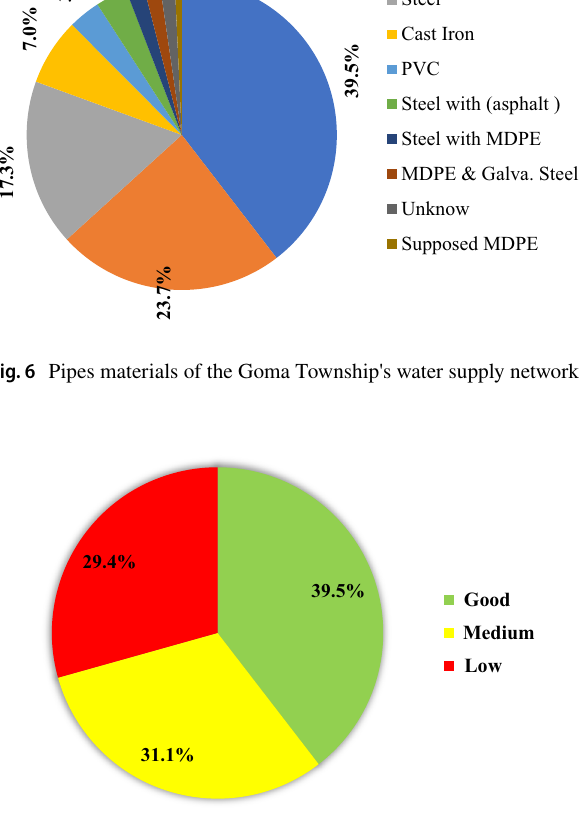
Fig. 7 Assessment of pipe